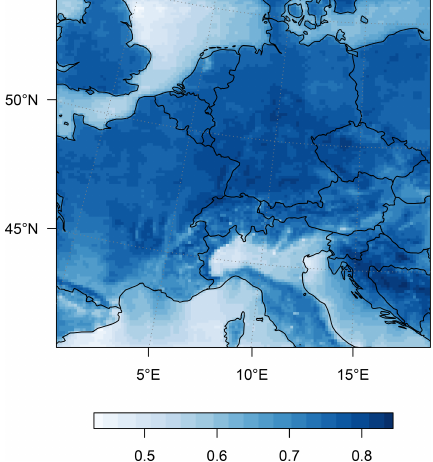
Figure C3. Temperature anomalies. Proportion of variance ex- plained ( R 2 ) for each grid cell for the temperature